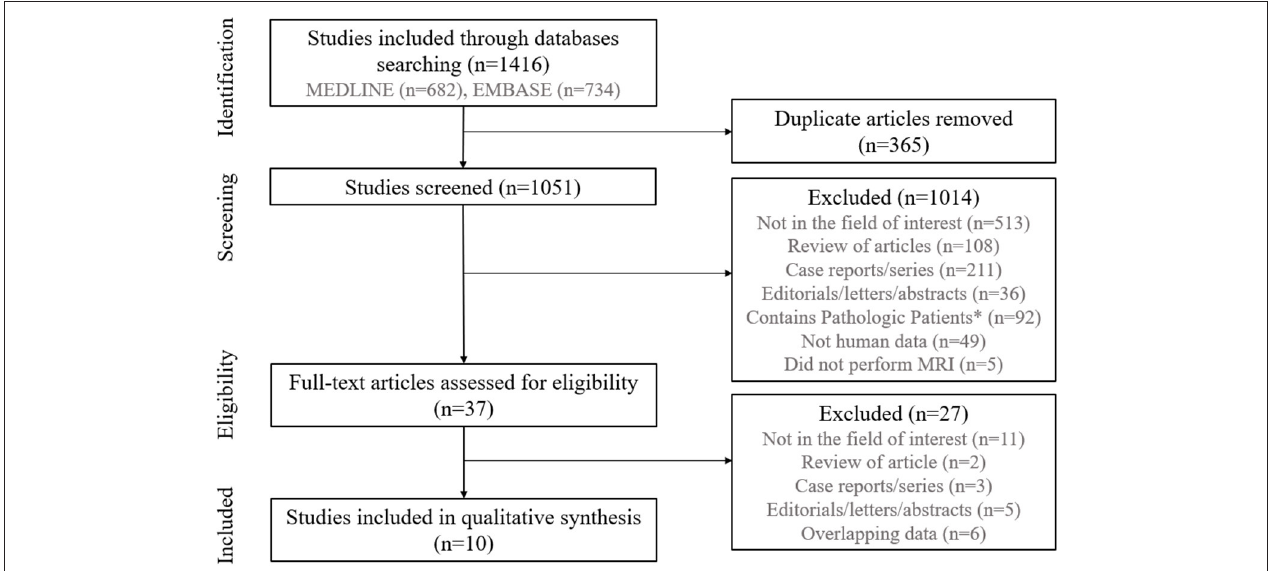
FIGURE 1 | Flow diagram of the study selection process. *Patients with neurodegenerative diseases, hydrocephalus, traumatic brain injury, cerebrovascular disease, cerebral demyelinating disease, cerebral metabolic disease, epilepsy, and/or solid brain tumors were